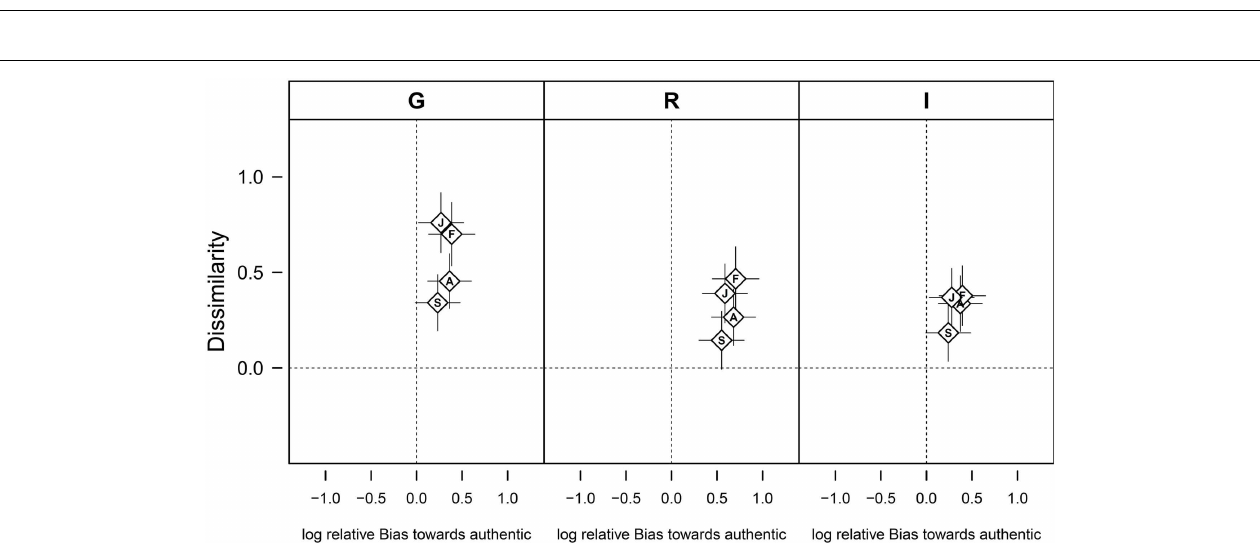
FIGURE 1 | Probability of correct authenticity recognition by intended emotion (A – anger, F – fear, J – joy, S – sadness) and stimulus authenticity (authentic or play-acted). The data are split by cultural